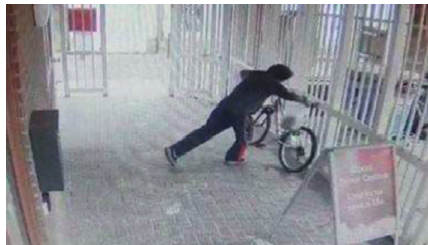
Figure 17: The thief stole the bike